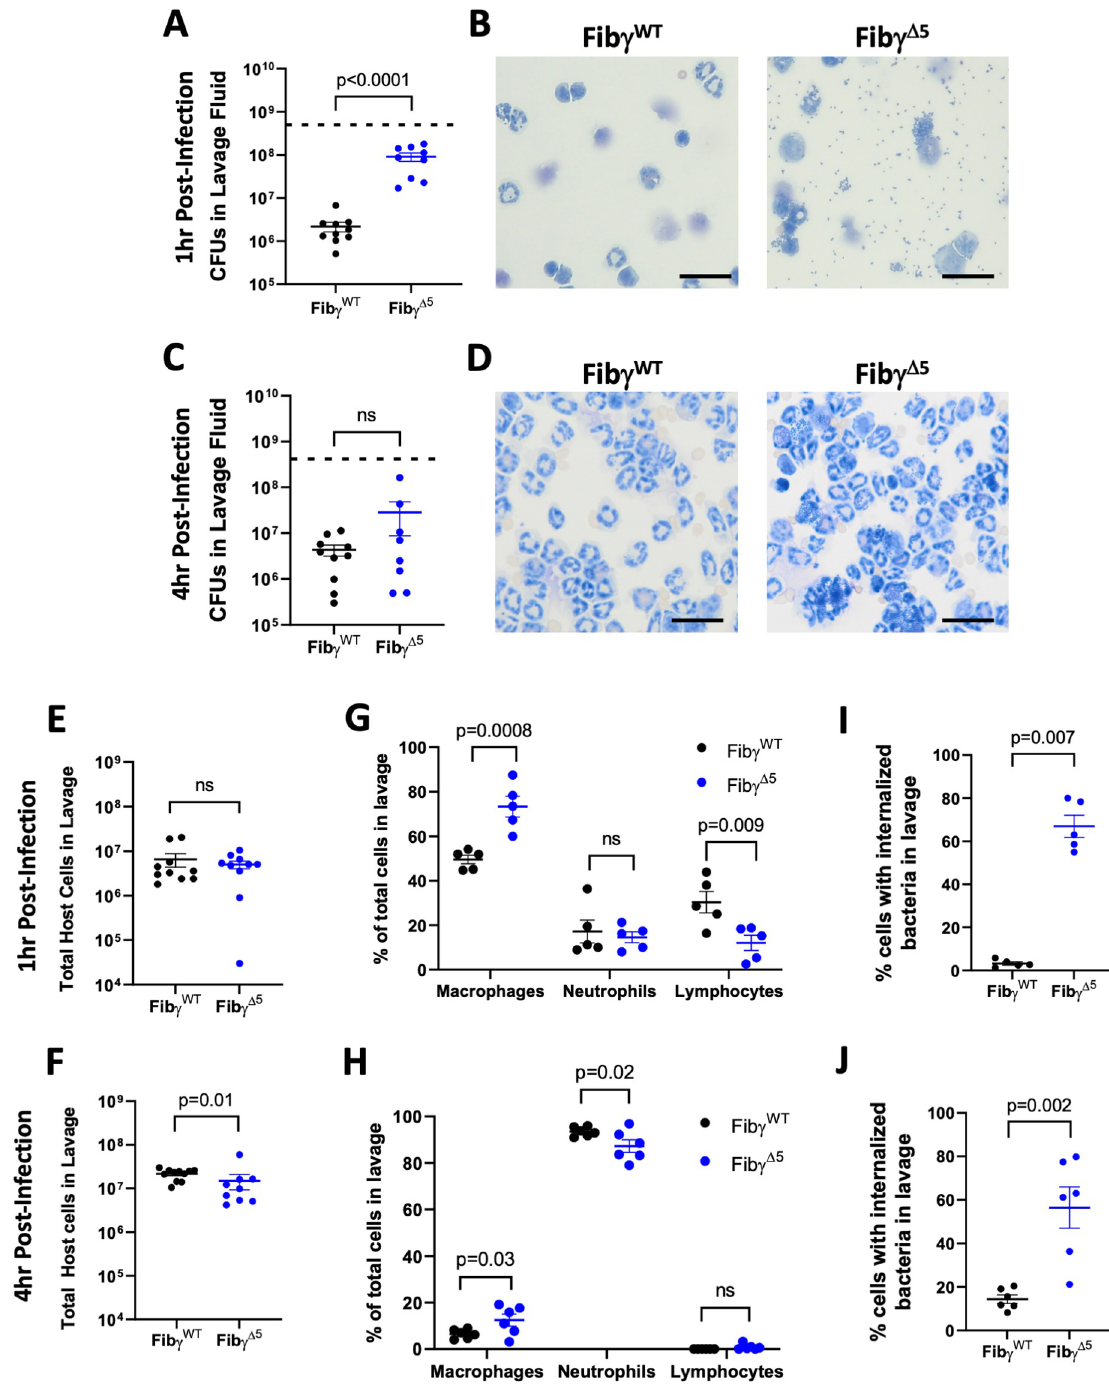
Fig 3. Fib γ Δ 5 mice display increased S. aureus CFUs in the peritoneal cavity following infection. (A) Total bacterial CFUs in peritoneal lavage fluid of Fib γ WT and Fib γ Δ 5 mice 1 hour after i.p. infection with 5x10 8 CFUs of WT USA300 S . aureus . (B) Representative images of cytospin preparations of peritoneal lavage fluid collected from Fib γ WT and Fib γ Δ 5 mice 1hr after i.p. infection with 5x10 8 CFUs USA300 S . aureus . Note the presence of extensive free-floating bacteria in Fib γ Δ 5 mice compared to Fib γ WT . (C) Total CFU in the peritoneal lavage fluid of Fib γ WT and Fib γ Δ 5 mice 4 hours after i.p. infection with 4x10 8 CFUs of WT USA300 S . aureus . (D) Representative images of cytospin preparations of peritoneal lavage fluid collected from Fib γ WT and Fib γ Δ 5 mice 4 hours after infection. CFU data is presented as mean ± SEM and statistical significance was determined by Mann-Whitney u-test. Dashed horizontal lines indicate the infection dose. Images were captured with 40x objective with scale bar representing 20 μ m. Total cell counts from peritoneal lavage fluid 1 hour (E) and 4